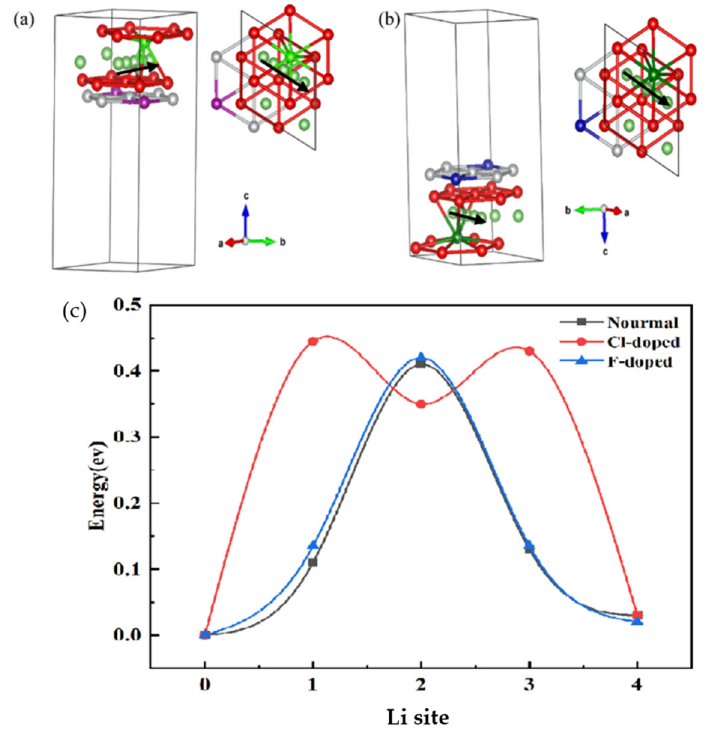
Figure 13. Diffusion distribution of Normal, Cl-doped and F-doped cells in lithium layer near doping position.( a ) the TSH diffusion pathway of Li in Cl-doped, ( b ) the TSH diffusion pathway of Li in F-doped, ( c ) The NEB energy profiles. Color code for spheres: green-Li atoms, grey-Ni atoms, violet-Mn atoms, red-O atoms, blue-Co atoms, Light green-Cl atom, Dark green-F atom. The arrow indicates the diffusion path of Li 1 to Li 5 .